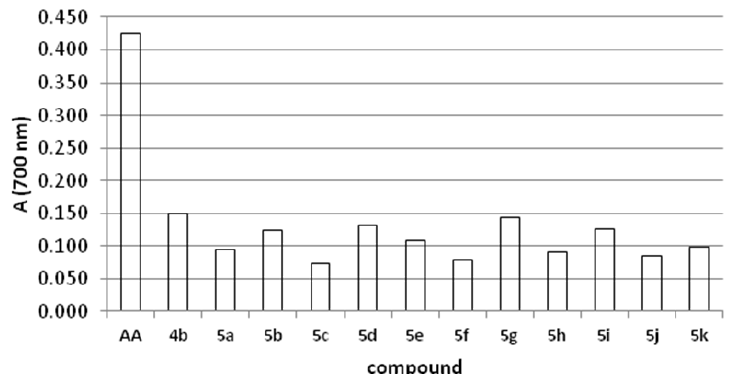
Figure 1. Reducing power of tested thiadiazine derivatives.